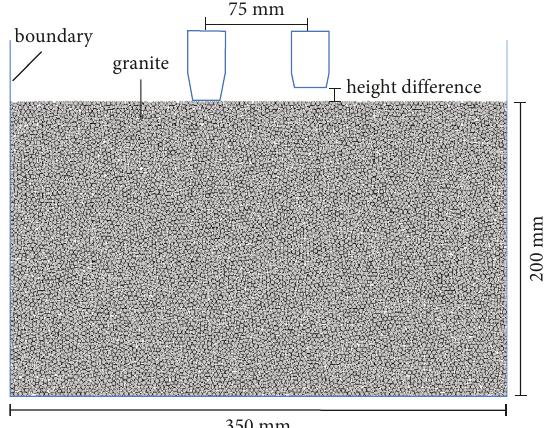
Figure 7: Numerical calculation model of rock breaking by disc